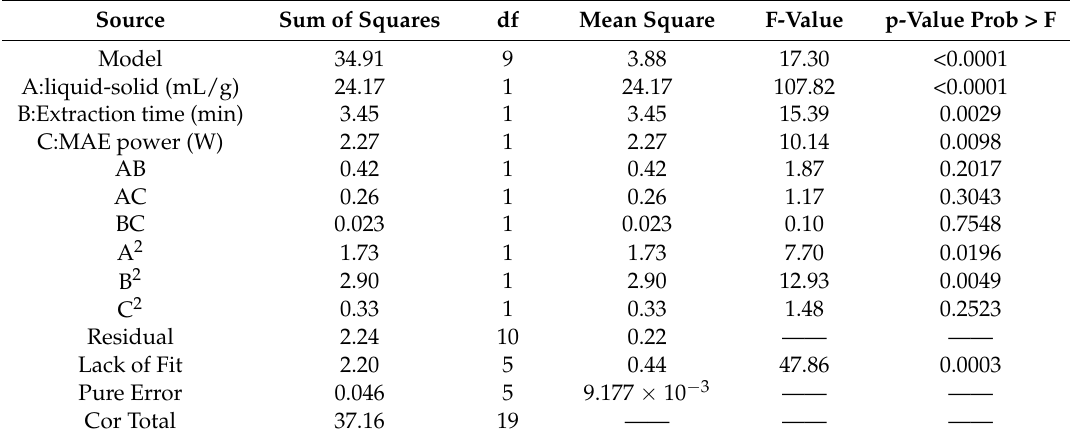
Table 2. Test of significance for regression coefficient for microwave-assisted extraction.